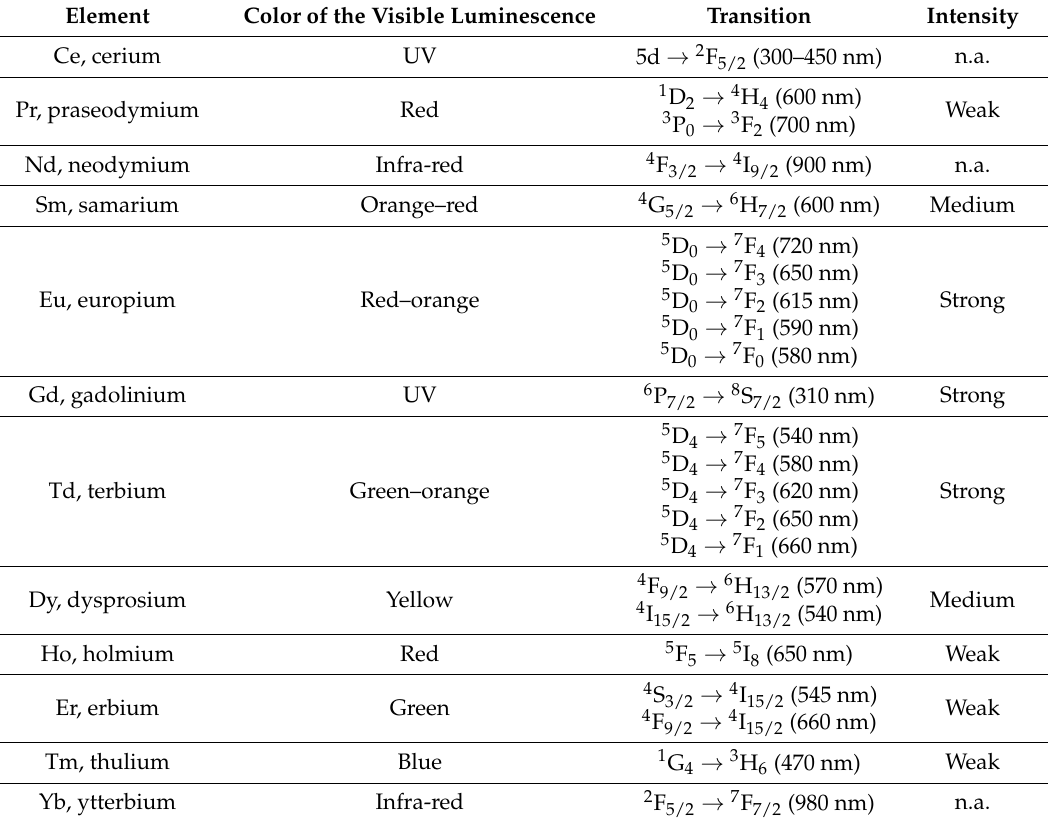
Table 1. Transitions of lanthanide elements